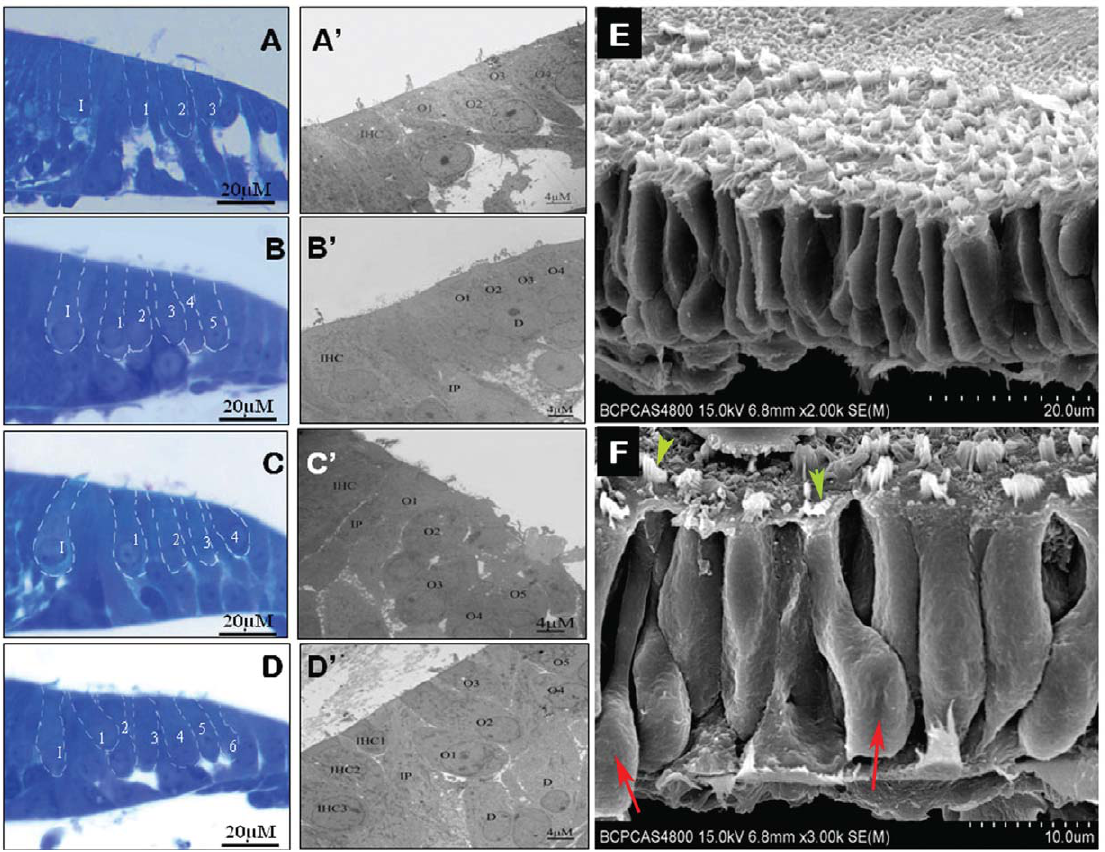
Figure 3. The semi-thin (A, B, C, D) and ultrastructural micrographs (A 9 , B 9 , C 9 , D 9 ) of the cochlear epithelia. A, A 9 : Control culture; B, B 9 : Cultured Organ of Corti infected with adeno-Atoh1-EGFP; C, C 9 : Cultured Organ of Corti treated with DATP; D, D 9 : Cultured Organ of Corti with Atoh1 over expression plus DAPT treatment. E and F: Scanning electron microscopic image of the DAPT treated Organ of Corti. F: the enlarged picture of another optical field showing the lateral view of the cultured sensory epithelia. There were two cells (red arrows) whose bodies are very similar to that of Deiters’ cells, but there were also hair bundles (green arrow heads) on their top face, which might indicate that the extra hair cells came from the trans-differentiation of immature Deiters’ cells.